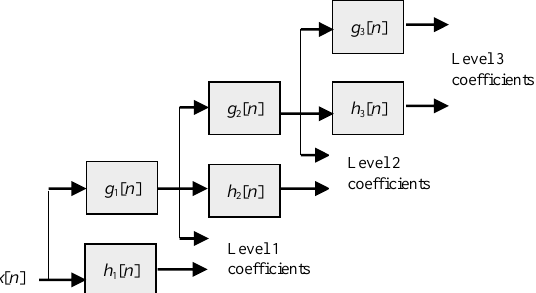
Figure 4. Three-level wavelet decomposition of signal x [ n ] using low- and high-frequency filters ( g i [ n ] and h i [ n ], respectively).